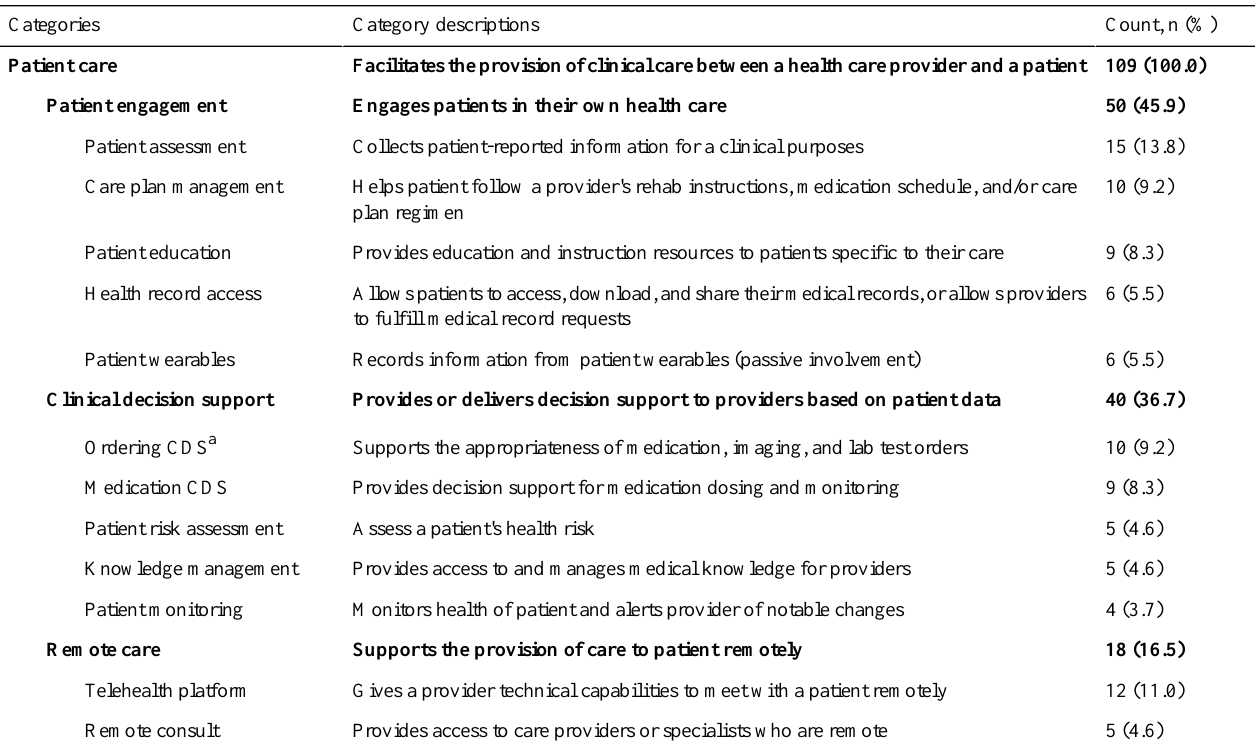
Table 4. Category definitions and counts for patient care apps (n=109).